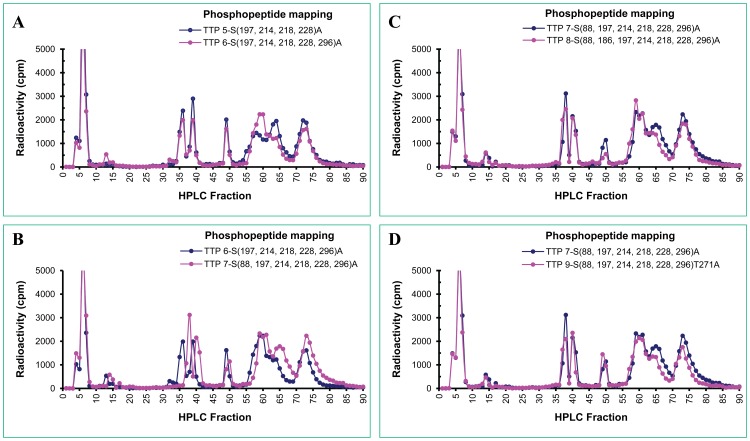
Phosphopeptide mapping of mutant hTTP proteins from transfected human cells.The methods for generating the phosphopeptide mapping profiles were identical to those described in Figure 6 legend. The phosphopeptide profiles in each pair of hTTP proteins are (A) S(197,214,218,228)A vs. S(197,214,218,228,296)A, (B) S(197,214,218,228,296)A vs. S(88,197,214,218,228,296)A, (C) S(88,197,214,218,228,296)A vs. S(88,186,197,214,218,228,296)A, and (D) S(88,197,214,218,228,296)A vs. S(88,197,214,218,228,296)T271A.